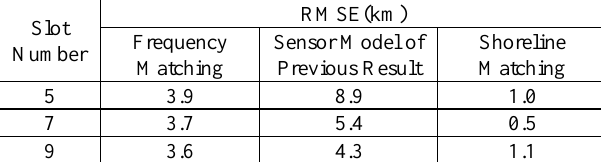
Table 2. RMSE comparison with existing method